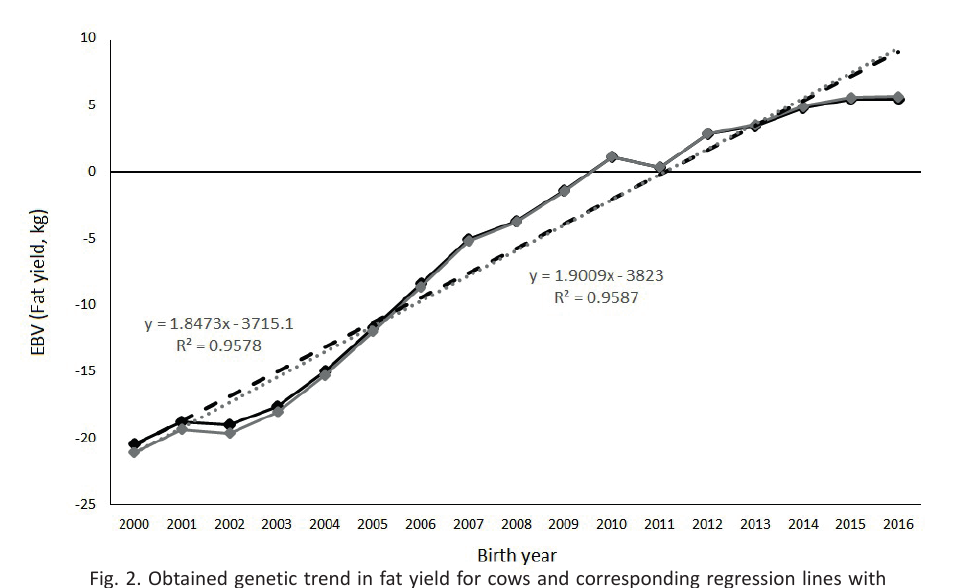
Fig. 2. Obtained genetic trend in fat yield for cows and corresponding regression lines with equation showing annual response using a single-lactation model (black lines) or a multi- lactation model (gray